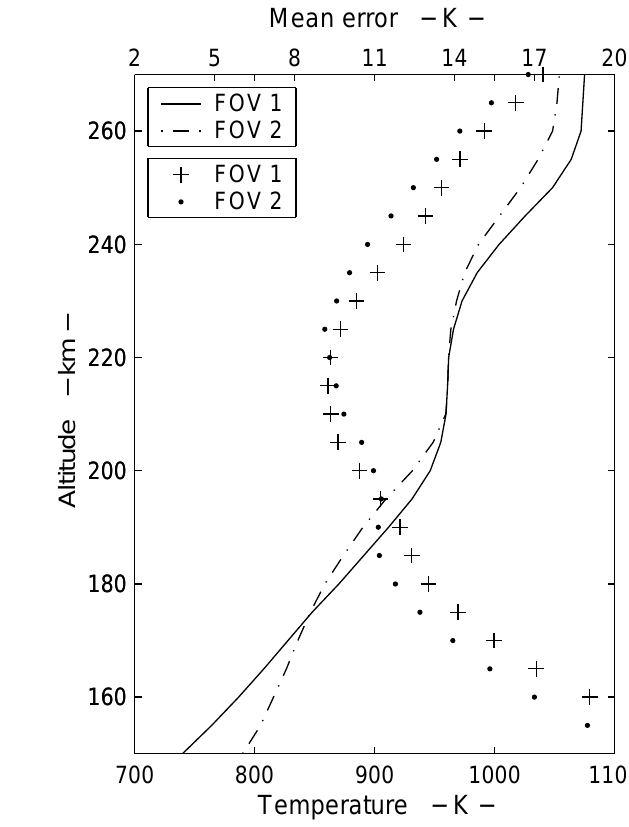
Fig. 2. Mean apparent temperature profiles for the two FOVs on UARS day 378. The mean errors are indicated by dots and crosses, and refer to the upper horizontal scale.